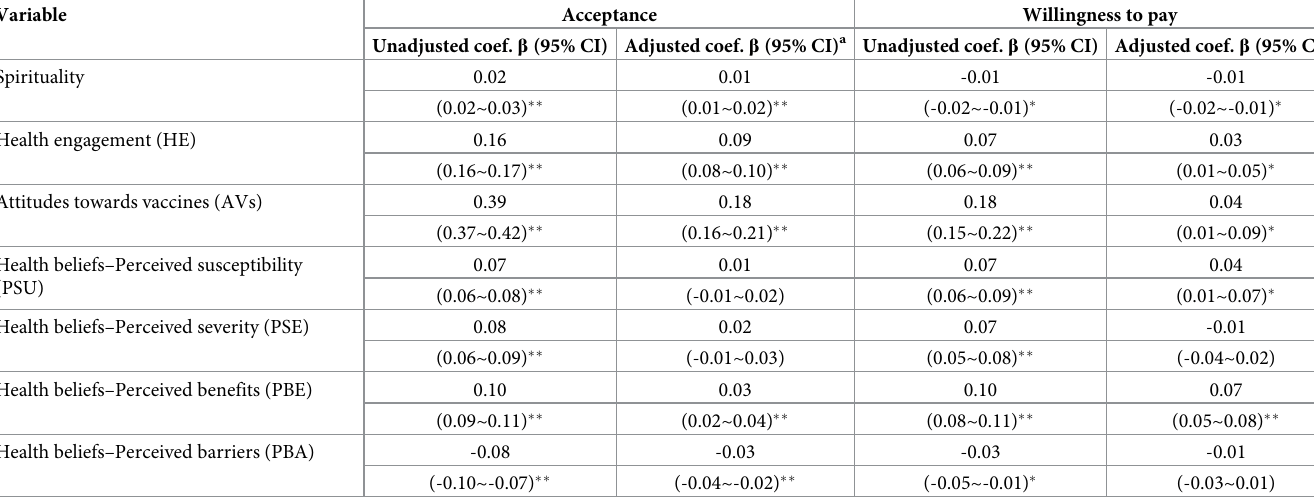
Table 3. Summary of linear regression analysis demonstrating citizen’s spirituality, health engagement, and attitudes with their acceptance and willingness to pay for the COVID-19 vaccine ( n = 1423).